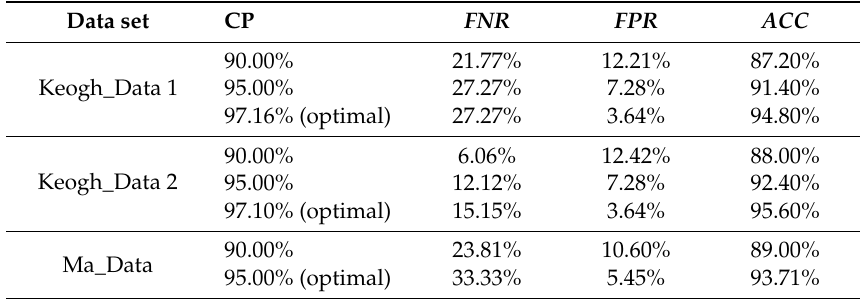
Table 1. Anomaly detection with different CPs based on relevance vector machine (RVM) model. ACC :